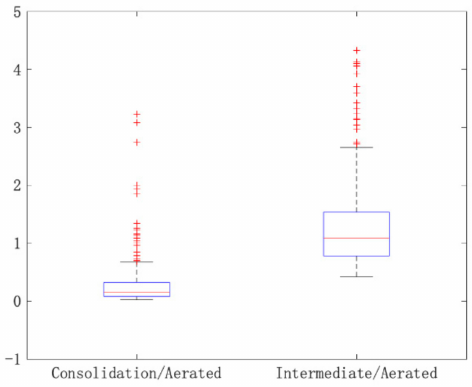
Figure 8. Boxplot of the volume ratios of the consolidated component compared to the aerated component and of the intermediate component compared to the aerated